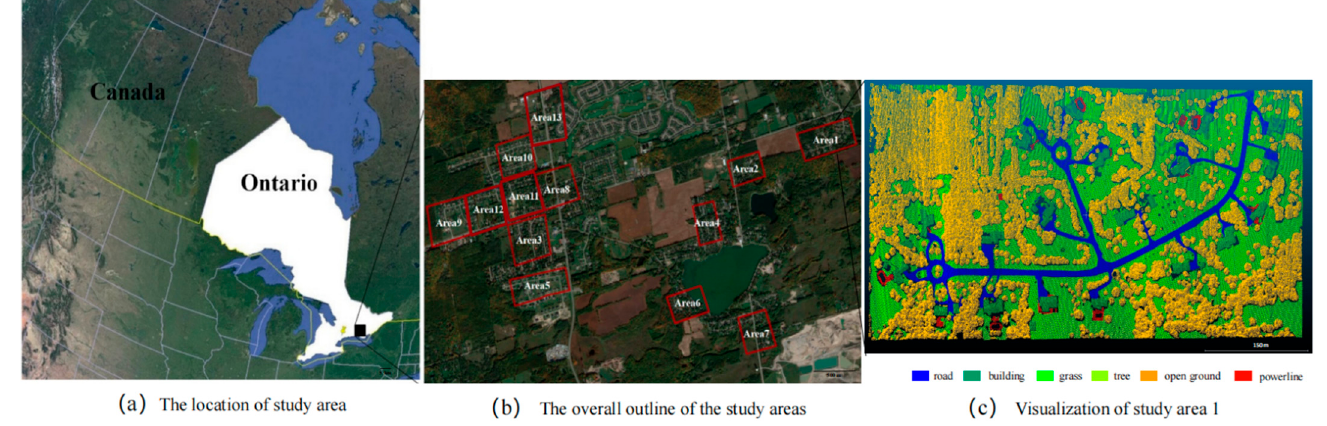
Figure 1. Presentation of the study areas.